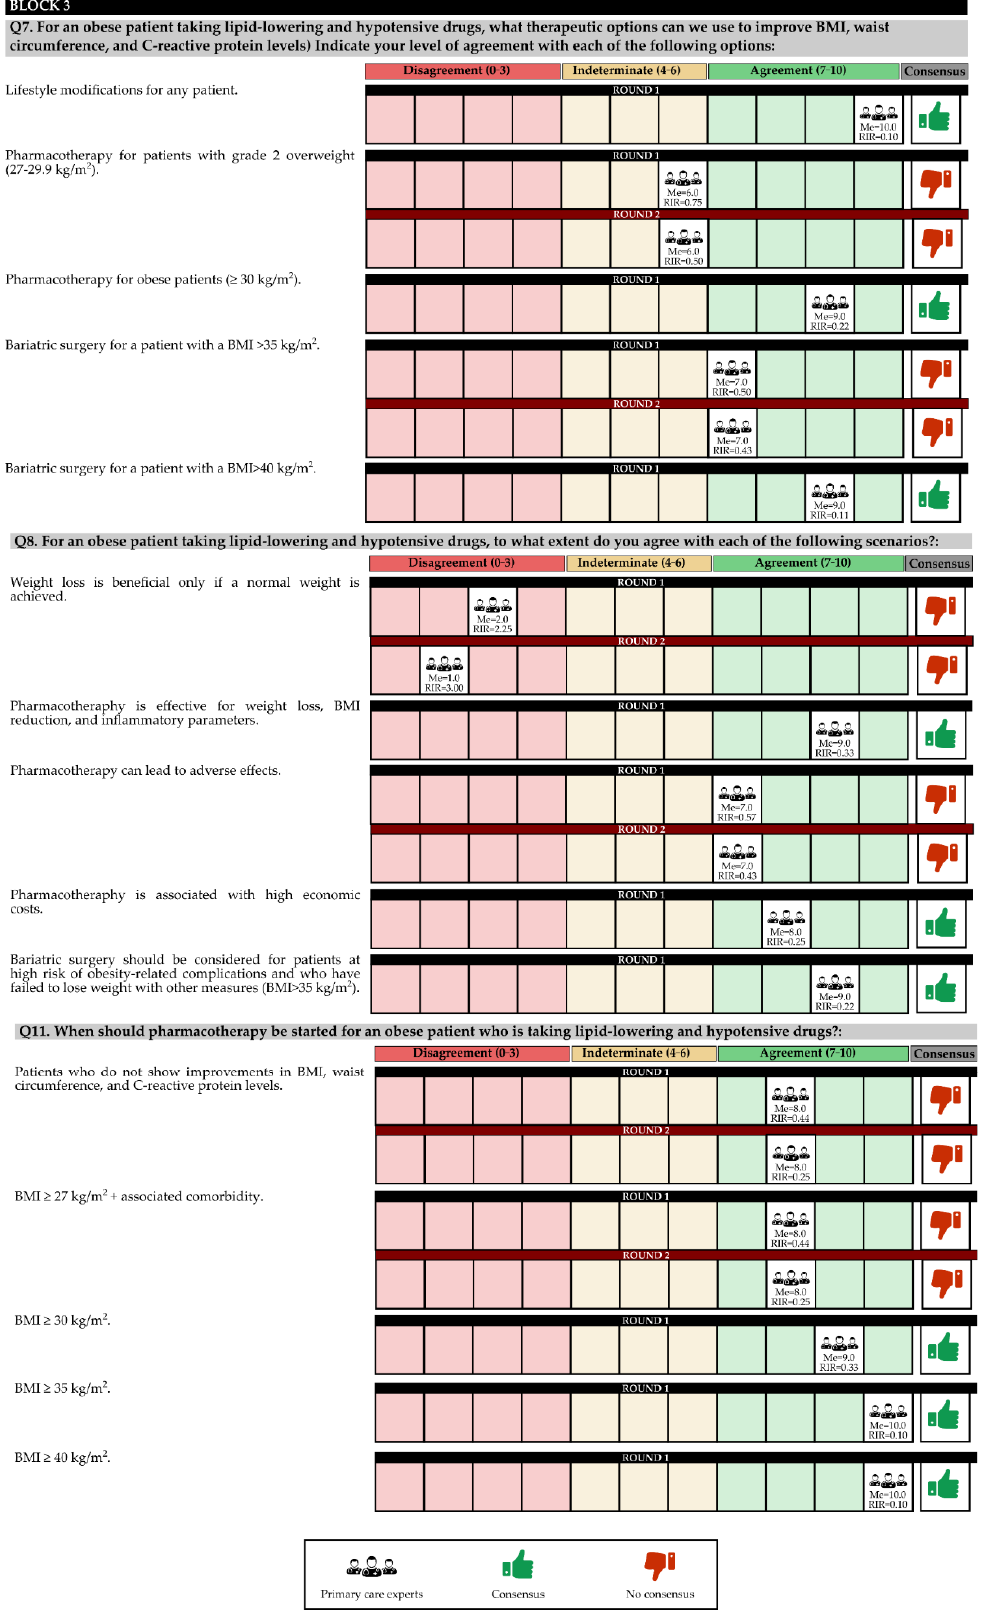
Figure 3. Discrete quantitative response questions of Block 2 under the Likert scale. IQR: Interquartile range; Me: